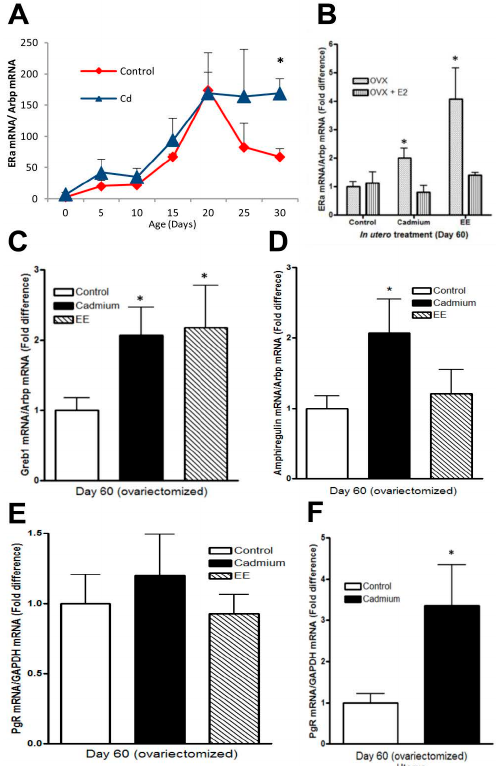
Figure 4. Effects of in utero exposure to cadmium on gene expression of ER α in the female offspring. Pregnant female rats were treated with cadmium (5 μ g/kg bw) or ethinyl estradiol (50 μ g/kg bw) as described in Figure 1 and the female offspring were examined. ( A ) In utero effects on ER α expression in the prepubertal mammary gland. The amount of ER α mRNA was measured on postnatal days 0, 5, 10, 15, 20, 25, and 30 by qRT-PCR assay and normalized to Arbp mRNA (mean ± SEM; n = 3–11 offspring/group; * p < 0.05); ( B ) in utero effects on the regulation of ER α in the adult mammary gland. Female offspring were ovariectomized on postnatal day 45. Beginning on postnatal day 56, the animals were treated daily with 17 β -estradiol. On postnatal day 60, the amount of ER α mRNA was measured by a qRT-PCR assay and normalized to Arbp mRNA. Data are presented as fold difference (mean ± SEM; n = 7–11 offspring/group; * p < 0.05); ( C – E ) in utero effects on gene expression in the adult mammary gland. Female offspring were ovariectomized on postnatal day 45. On postnatal day 60, the amount of Greb1 ( C ), amphiregulin ( D ), and PgR ( E ) mRNA was measured by a qRT-PCR assay, normalized to Arbp mRNA, and presented as fold difference (mean ± SEM; n = 7–11 offspring/group; * p < 0.05); ( F ) in utero effects on progesterone receptor expression in the adult uterus. Female offspring were ovariectomized on postnatal day 45. On postnatal day 60, uteri were excised and the amount of PgR mRNA was measured by a qRT-PCR assay, normalized to GAPDH mRNA, and presented as fold difference (mean ± SEM; n = 7–11 offspring/group; * p <